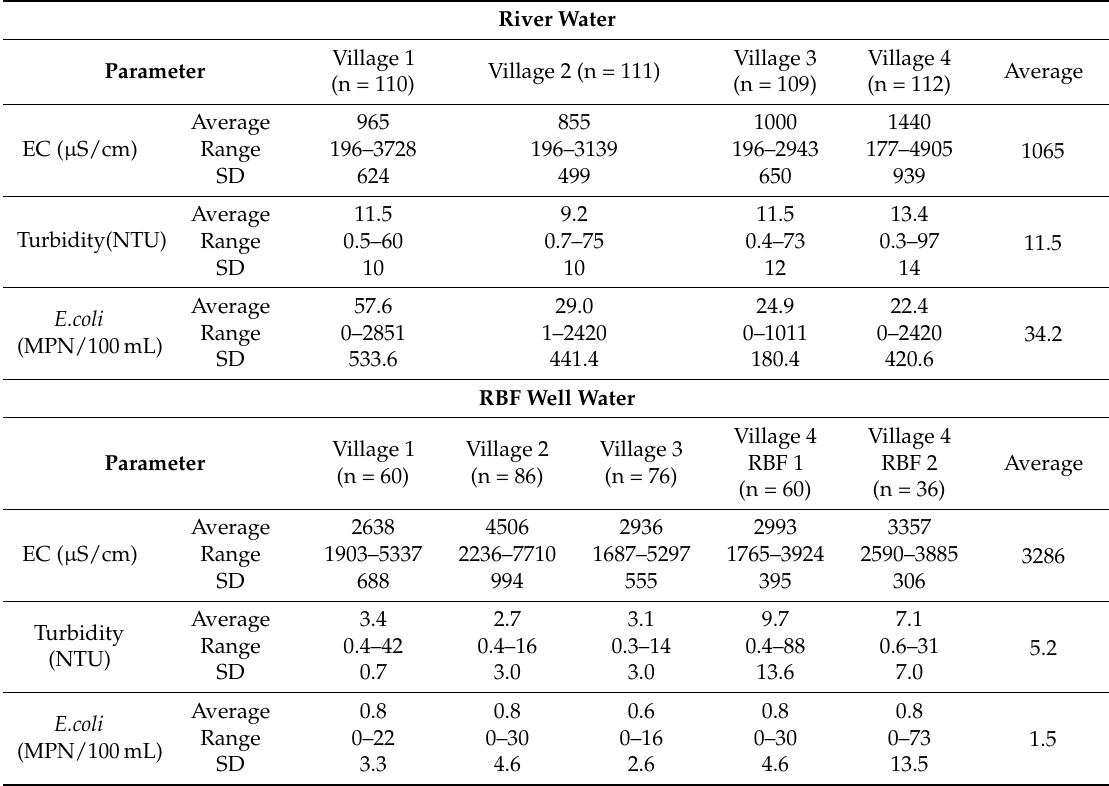
Table 2. Electric conductivity (EC), turbidity and E. coli data for RBF and river water